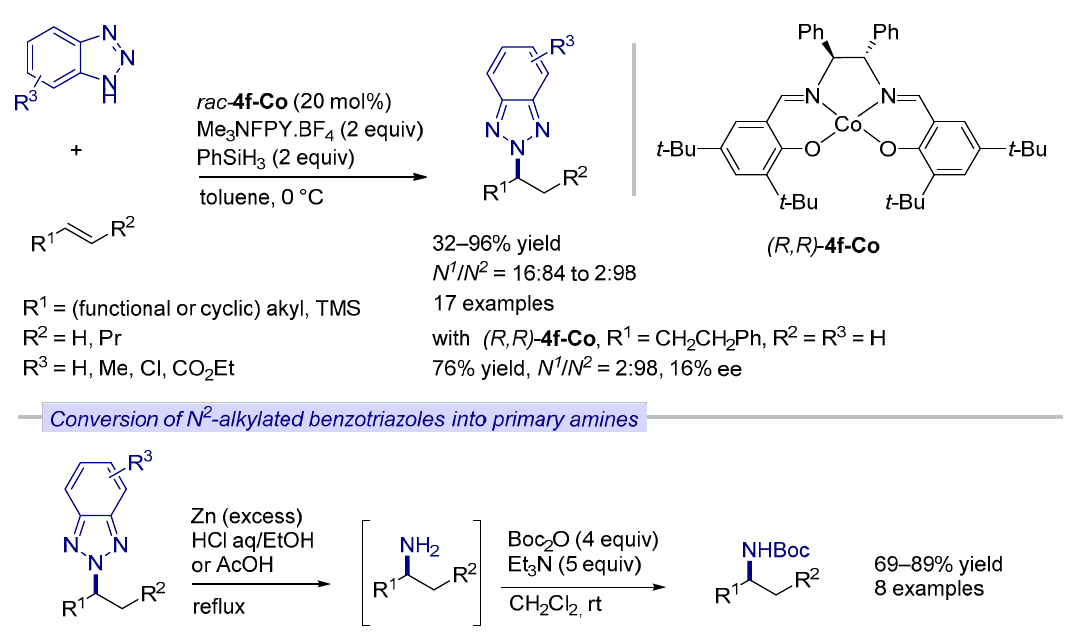
Figure 13. Cobalt-salen promoted Markovnikov selective hydroamination of benzotriazoles and terminal aliphatic and 13 conversion of N 2 -alkylated benzotriazoles products into primary amines. rt = room temperature, ee = enantiomeric